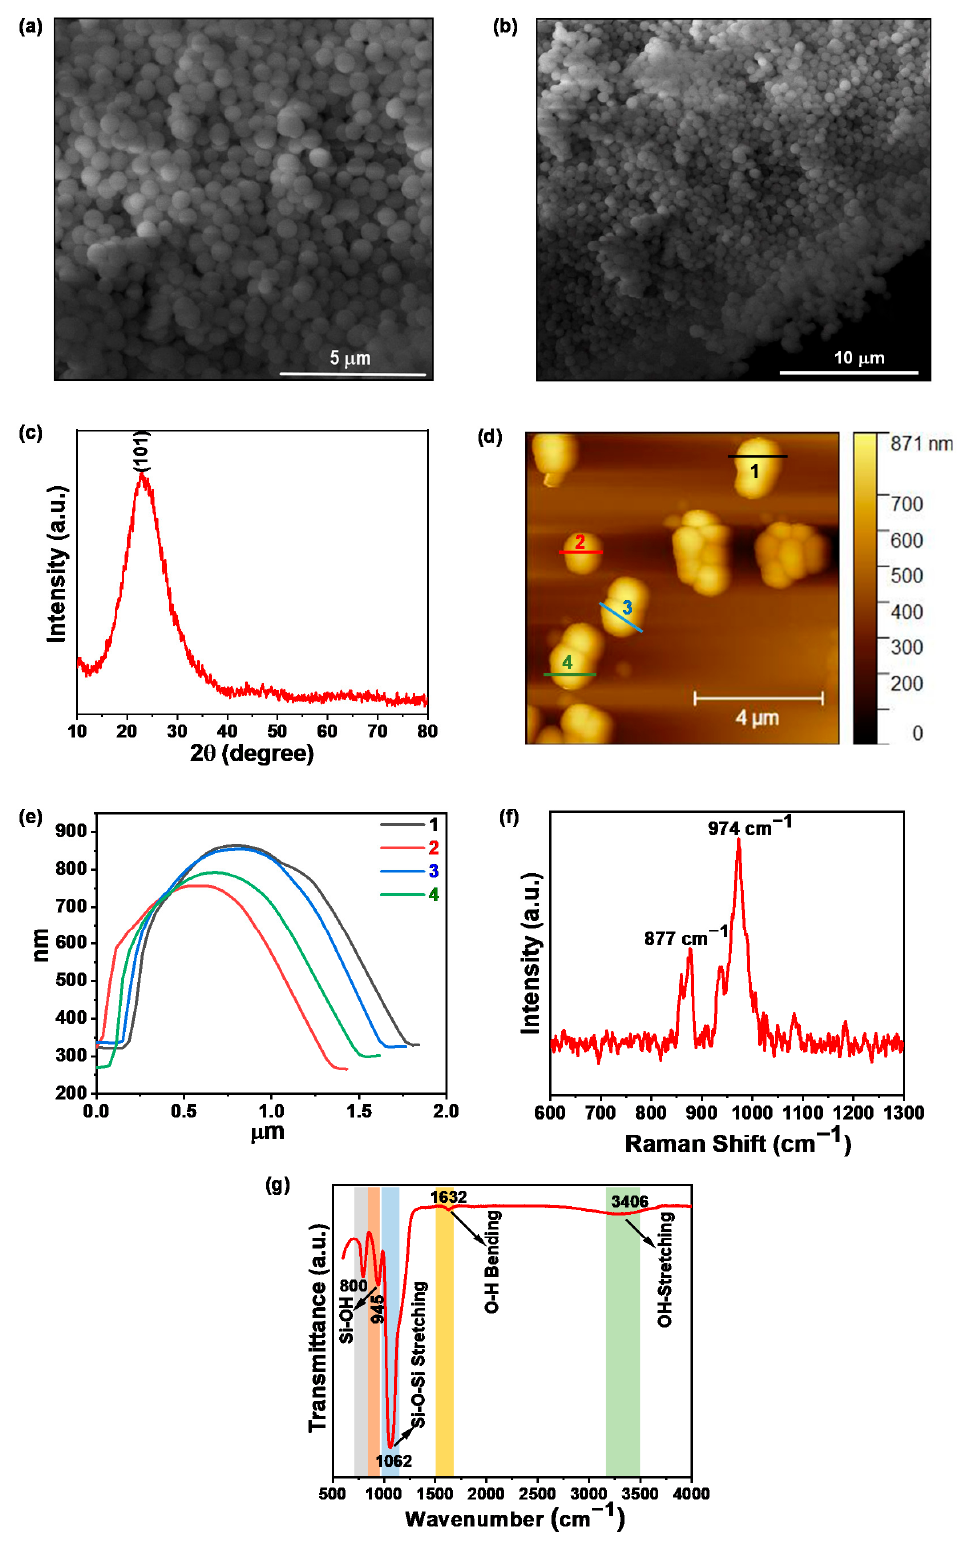
Figure 2. ( a , b ) SEM micrographs of SiO 2 nanoparticles at different magnifications; ( c ) typical XRD pattern of as-synthesized SiO 2 nanoparticles; ( d ) 2D topography of as-synthesized SiO 2 nanoparticles; ( e ) height profile of SiO 2 nanoparticles along the color-coded lines depicting the average size of nanoparticles ~500 nm; ( f ) Raman spectrum of as-synthesized SiO 2 nanospheres; ( g ) recorded FTIR spectrum of SiO 2